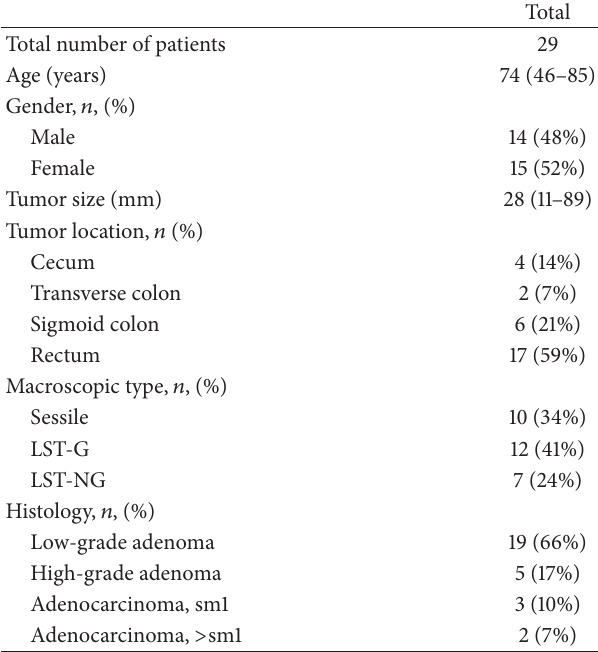
Table 1: Patient and tumor